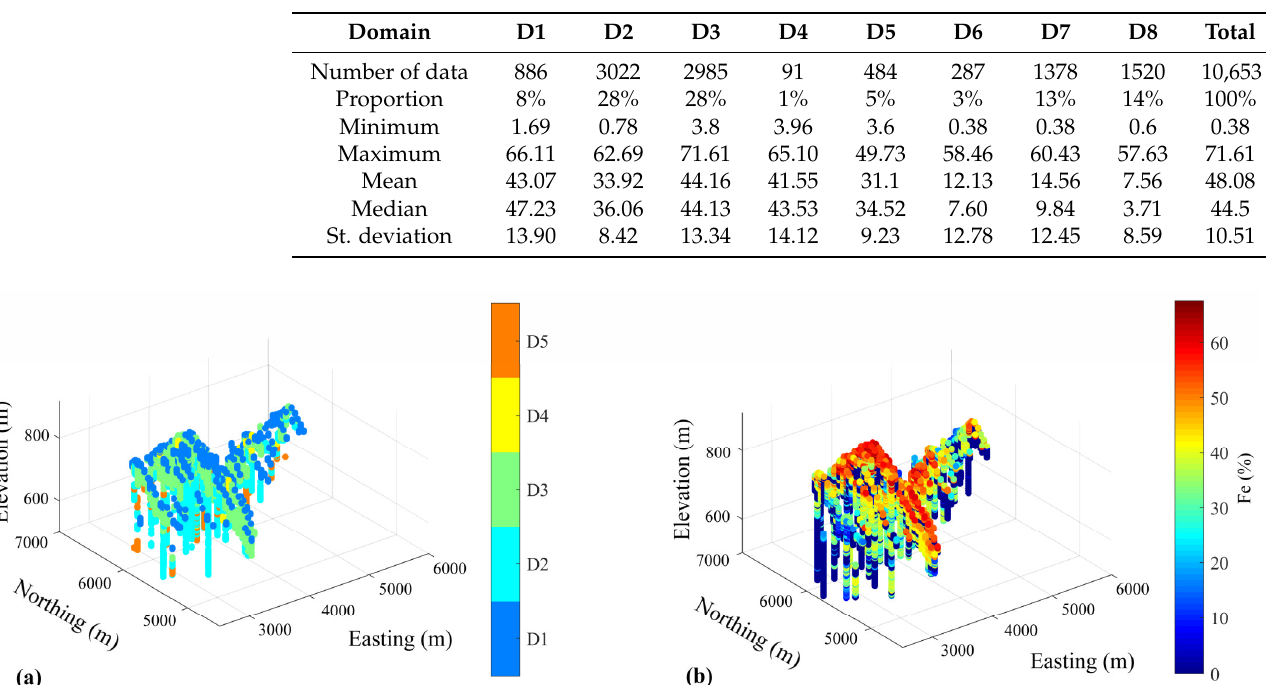
Table 2. Statistics of iron grade per geological domain.